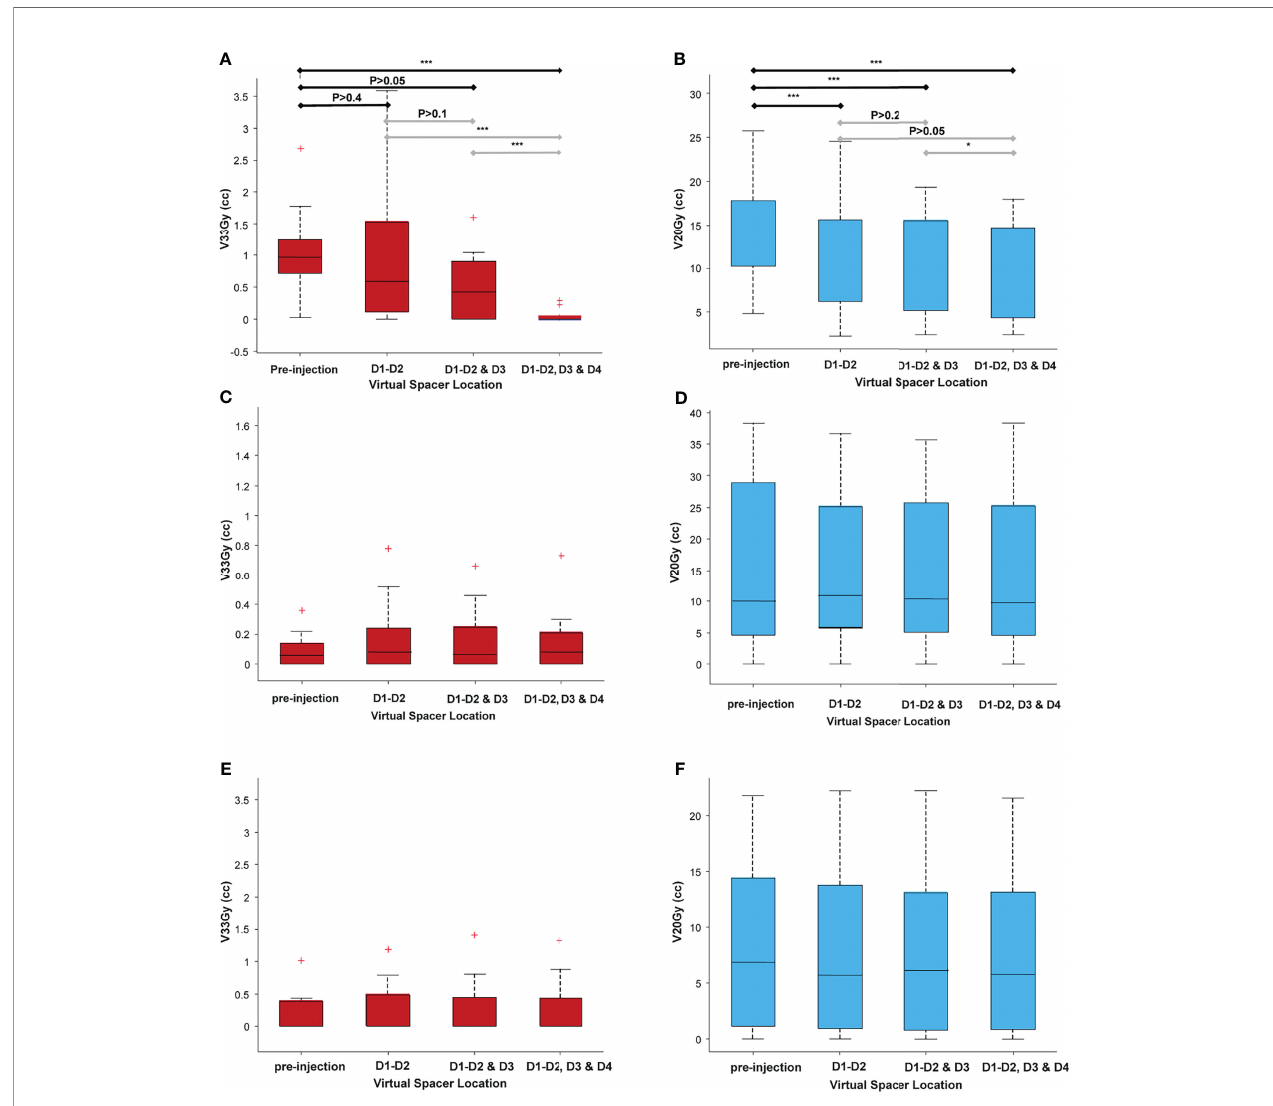
FIGURE 5 | A comparison of volume receiving high and low doses for all adjacent OARs (duodenum, stomach, and bowel), broken down for different scenarios. As seen, there is a statistically signi fi cant improvement in duodenal low-dose volume [20 Gy (B) ] independent of scenario (spacer location), as opposed to the duodenal high-dose volume [33 Gy (A) ] that highly depends on the location of the spacer. (C – F) The high-dose and low-dose volumes for bowel (C, D) and stomach (E, F) . There was no statistically signi fi cant difference between the volumes among the different scenarios, indicating that the duodenal spacer placement bene fi ts have the most effect on duodenal sparing and minimal effect on sparing the bowel and stomach. *P ≤ 0.05, **P ≤ 0.01, ***P ≤ 0.001, red + indicates outlier de fi ned as a value that is more than 1.5 times the interquartile range away from the bottom or top of the box. The double red pluses are just two outlier close to each